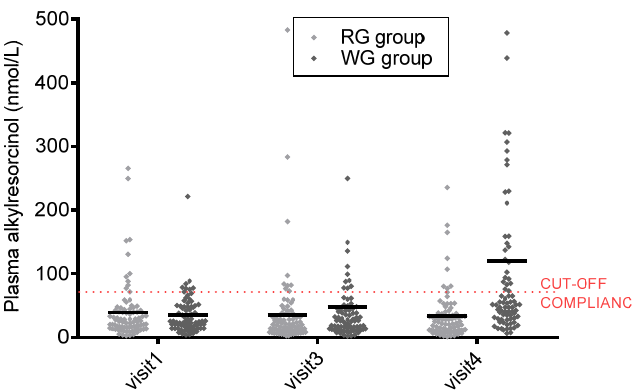
Figure 2. Mean and individual plasma alkylresorcinol concentration (nmol/L) for individuals by intervention at visit 1 (at baseline), visit 3 (after the low ‐ calorie diet (LCD) and run ‐ in periods), and visit 4 after the 12 ‐ week dietary intervention with either refined (RG) or wholegrain (WG) foods. For clarity, four subjects with plasma alkylresorcinol concentrations >500 nmol/L at visit 4 in the WG group have not been included.